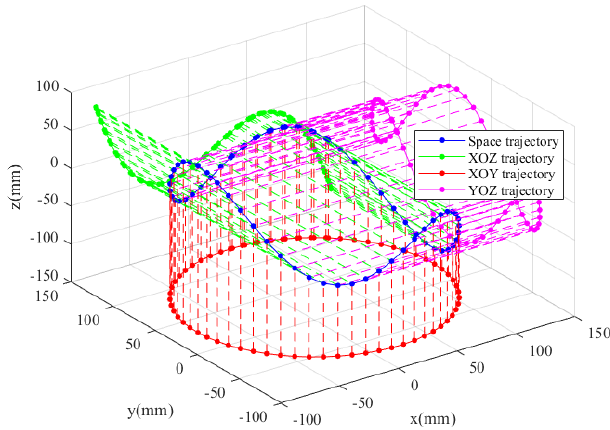
Figure 6. Space motion